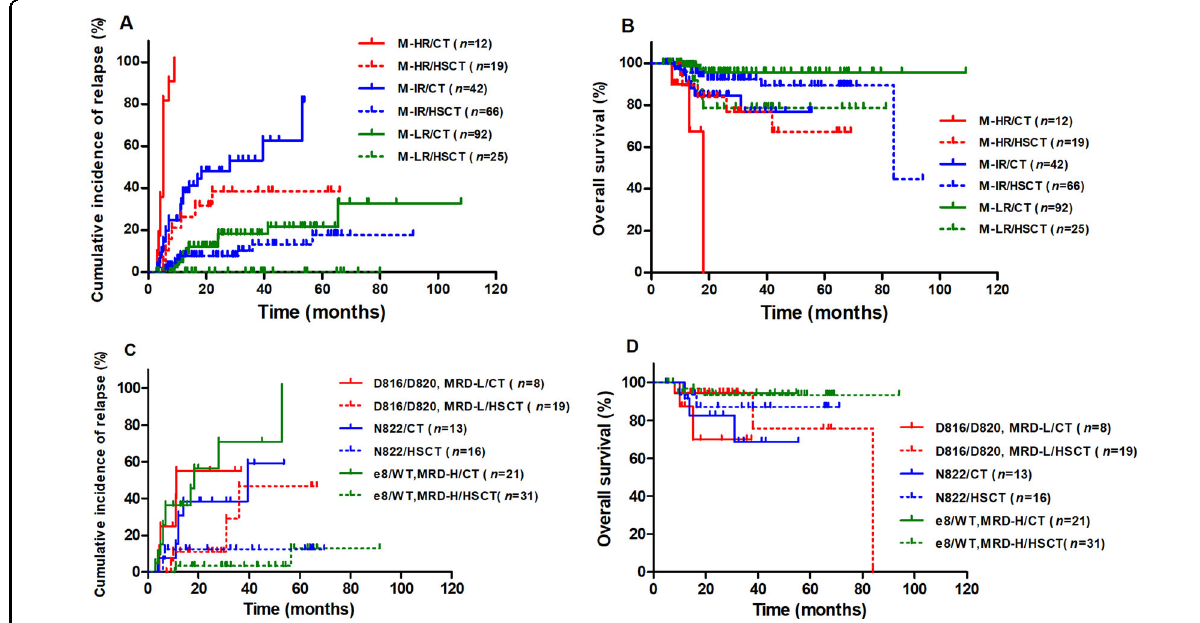
Fig. 2 CIR and OS of patients categorized by the molecularly de fi ned risk and treatment modality. A , C : CIR; B , D : OS. CT represented chemotherapy alone/auto-HSCT, HSCT represented